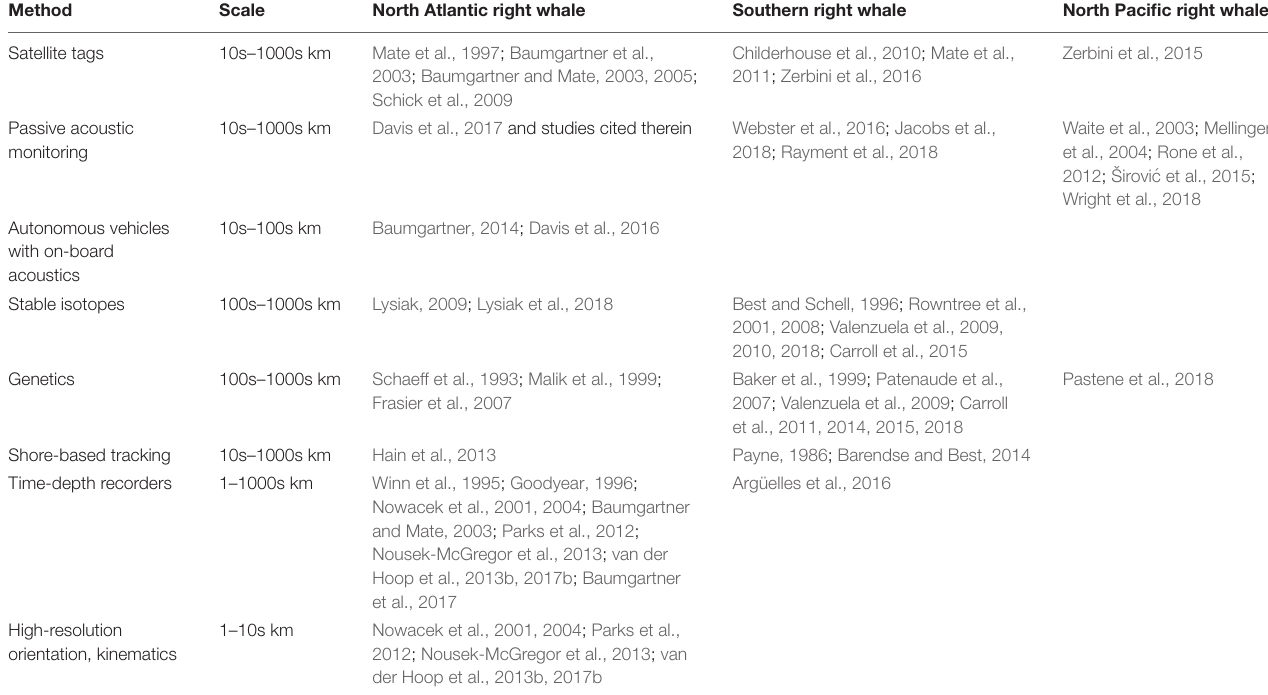
TABLE 1 | Tools for monitoring right whale occurrence and